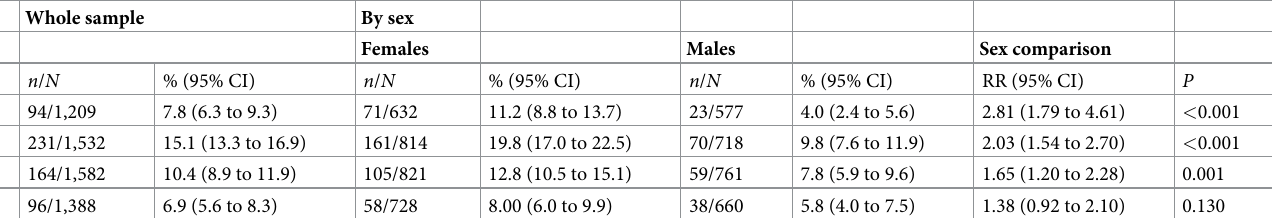
Table 2. Prevalence rates of suicidal ideation in the Bt20+ cohort. Whole sample By sex